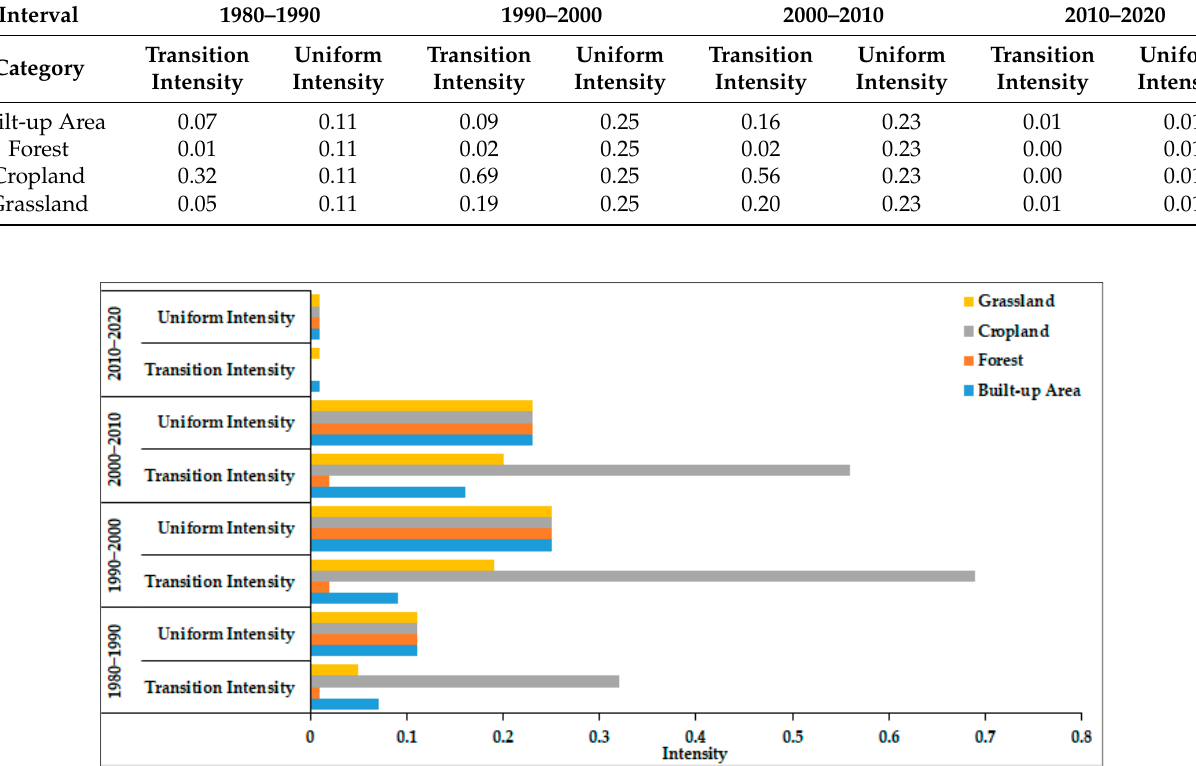
Table 23. Transition to Water.